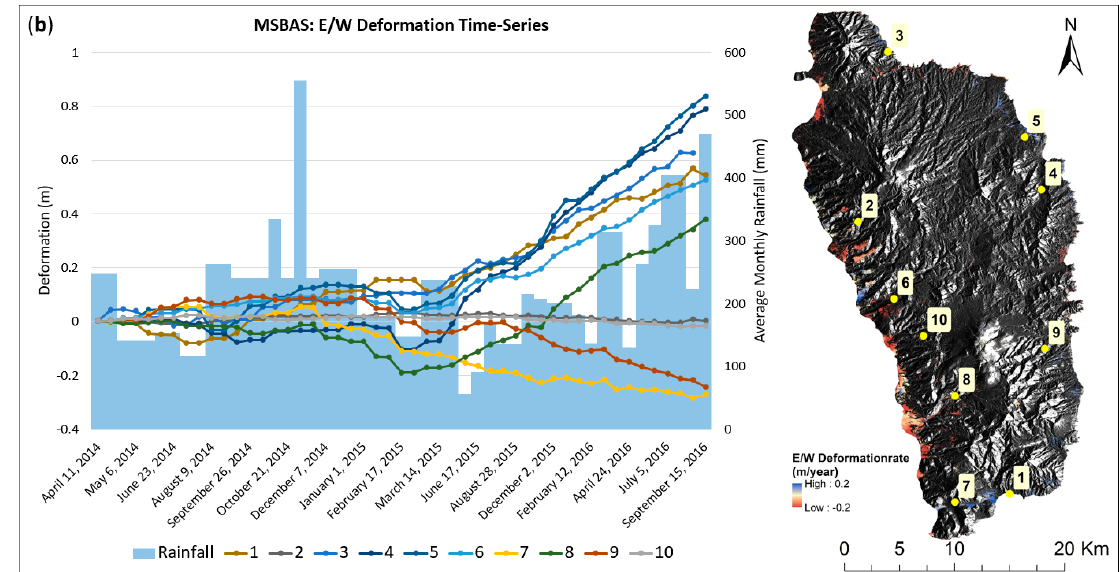
Figure 7. MSBAS time-series and deformation-rate maps of the components of motion in the ( a ) up/down (U/D) and ( b ) east/west (E/W) directions overlain on a SAR image. ( a , b ) also show up/down and east/west differential deformation rates, respectively.